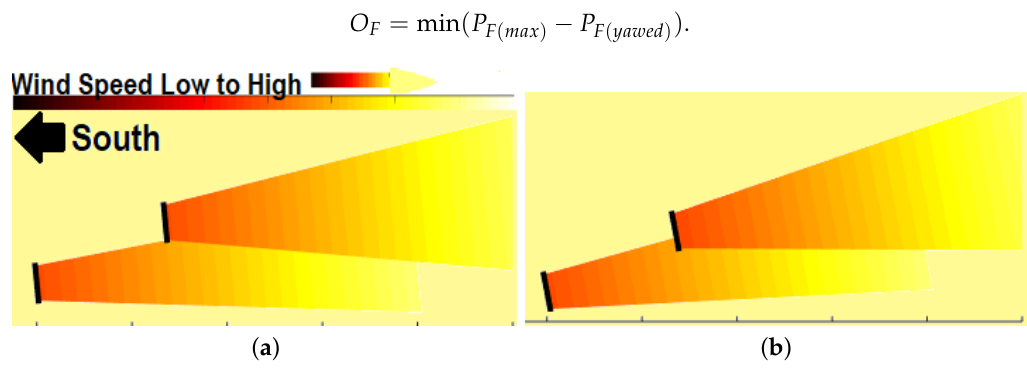
Figure 5. Wake effects of SMV6 on SMV5 in ( a ) 180 ◦ –185 ◦ ; ( b ) 186 ◦ –190 ◦